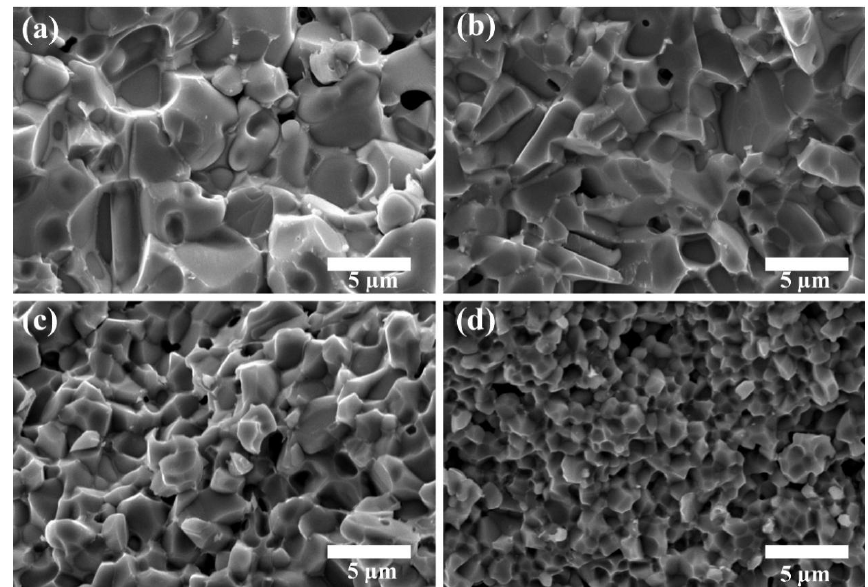
Fig. 4 SEM patterns of flash-sintered samples with different SiO microstructure was investigated. The microstructures